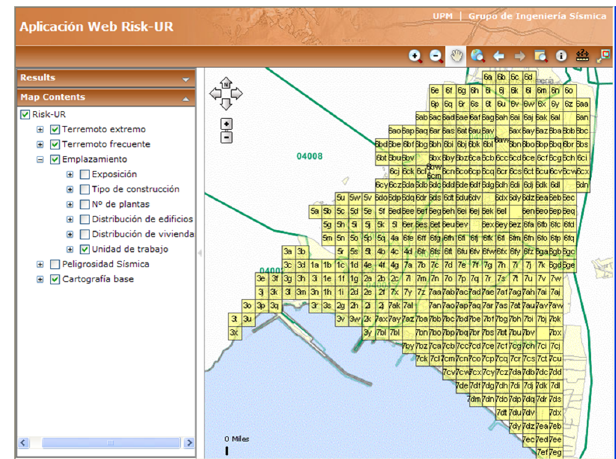
Fig. 1. Web visualiser showing the working